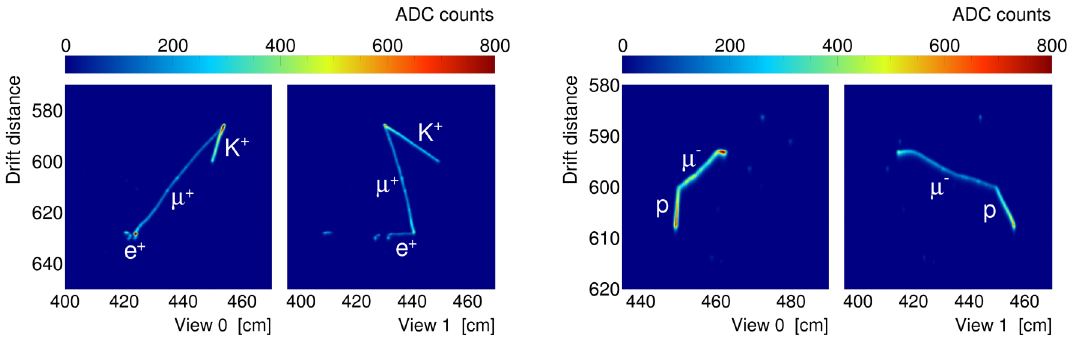
Figure 4 . Example event displays for simulated proton decay via p → ¯ νK + (left) and for a ν µ charged current quasi elastic (CC QE) scatter on a neutron